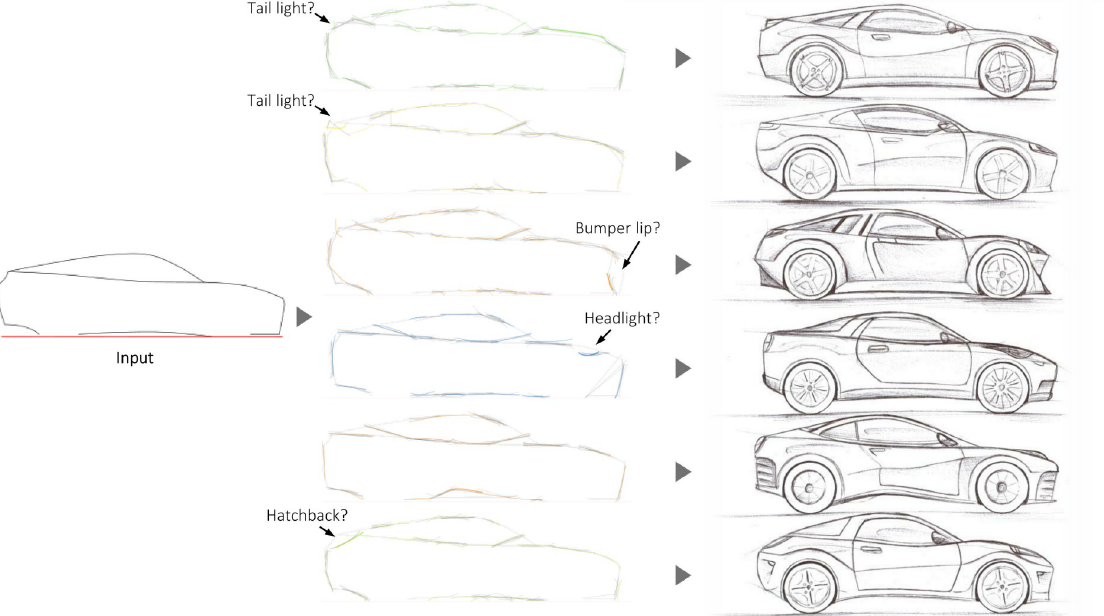
Fig 14. Shapi variations of the silhouette of a car (center column) where some characteristics may be considered ‘emergent’ features. On the right, some reinterpretations of how a designer might continue the ideation conversation. The Seed is based on an exploration by an interior photographer [93].